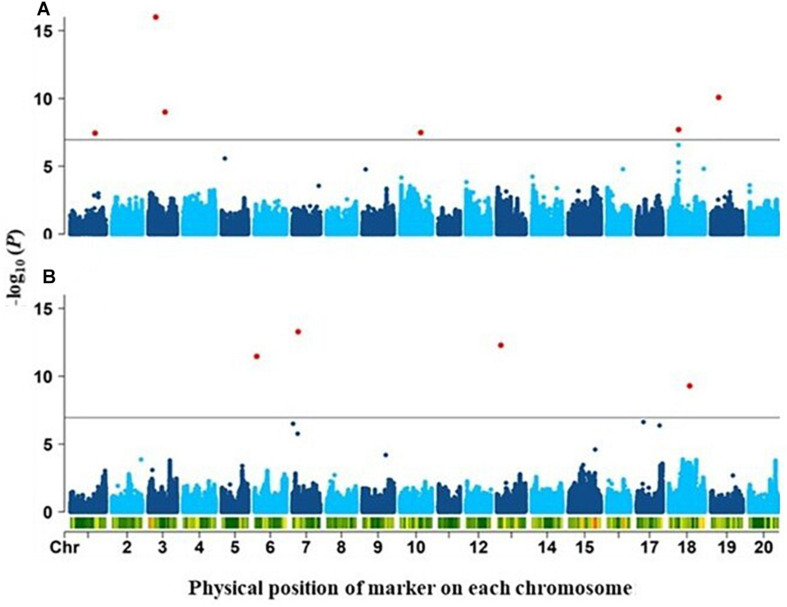
Manhattan plots of the genome-wide association results for (A) total length of roots (TLR) and(B) diameter of roots (DR). Negative log10 (P-values) (y-axis) describing the strength of the association between each marker and trait are plotted against the physical position of each marker (x-axis). The green horizontal line indicates the significance threshold (FDR = 5%) and significant associations are colored in red.